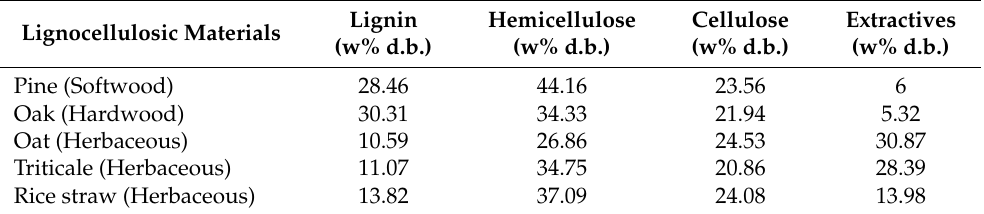
Table 5. Lignocellulosic materials composition [57].